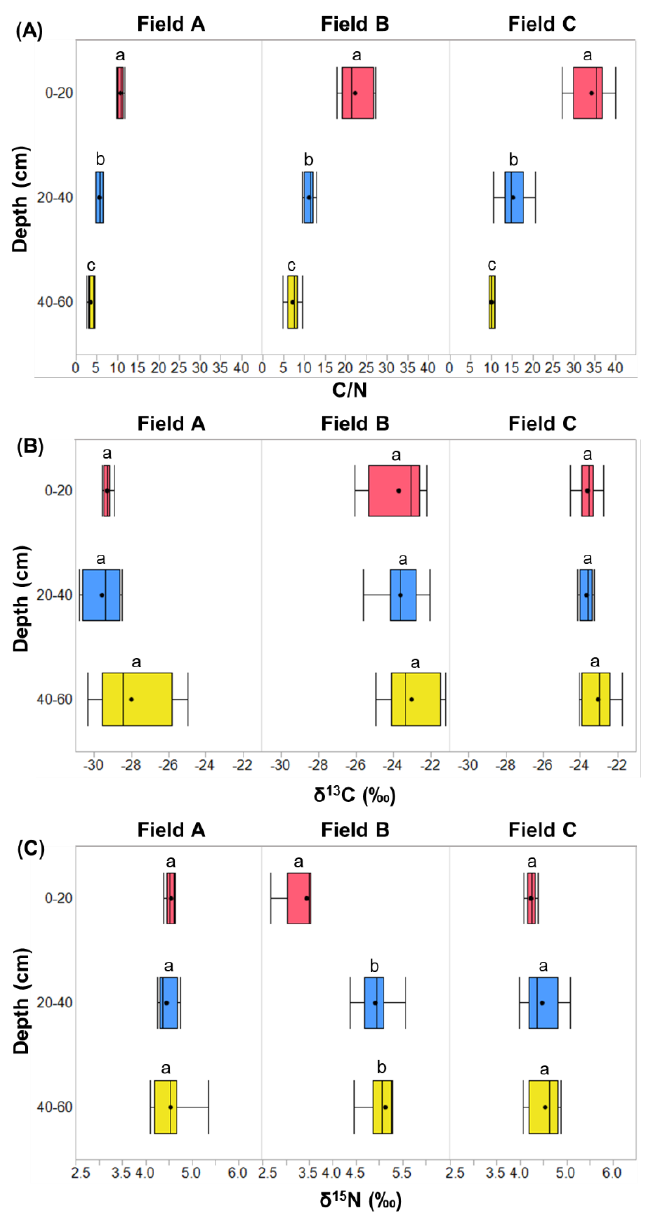
Figure 4. Median, mean (point), 25 th , and 75 th percentile of ( A ) C / N ratios, ( B ) δ 13 C, and ( C ) δ 15 N across depths in three fields. The different letters indicate significant differences among the three depths ( p < 0.05) for each field.